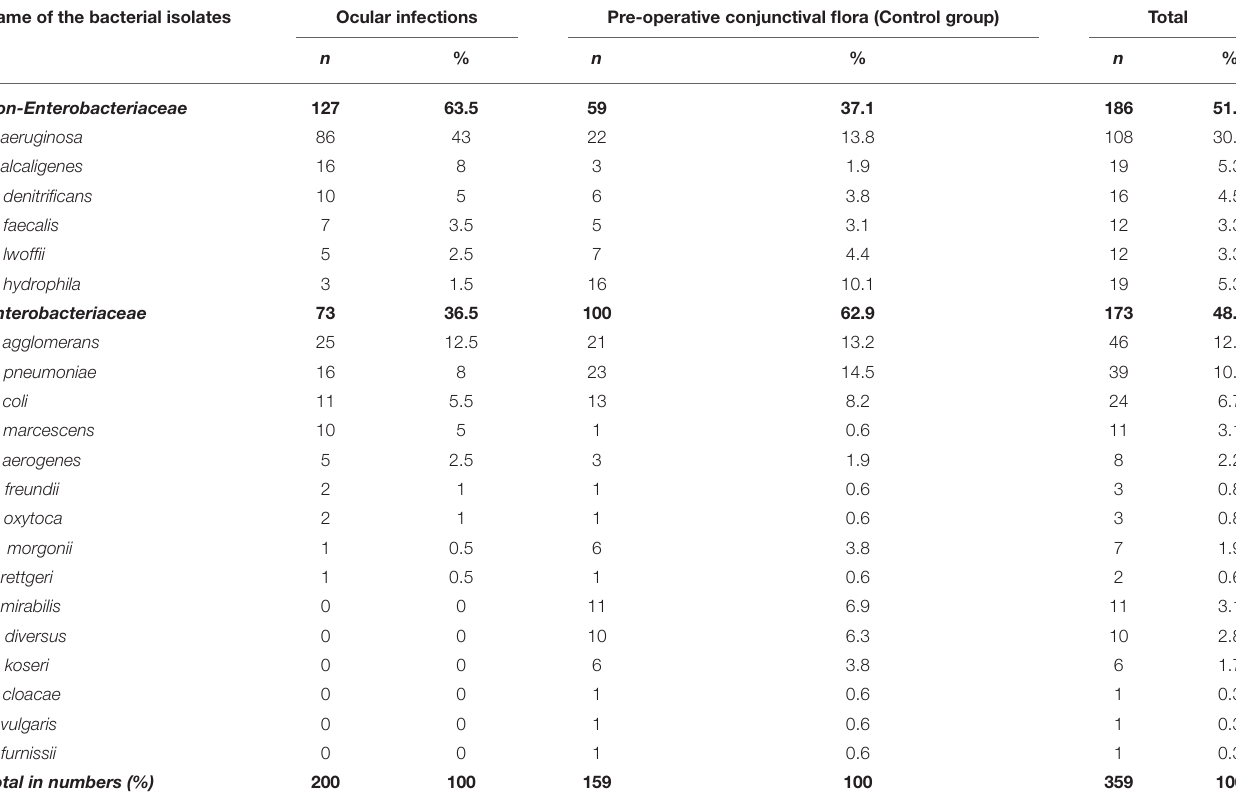
Name of the bacterial